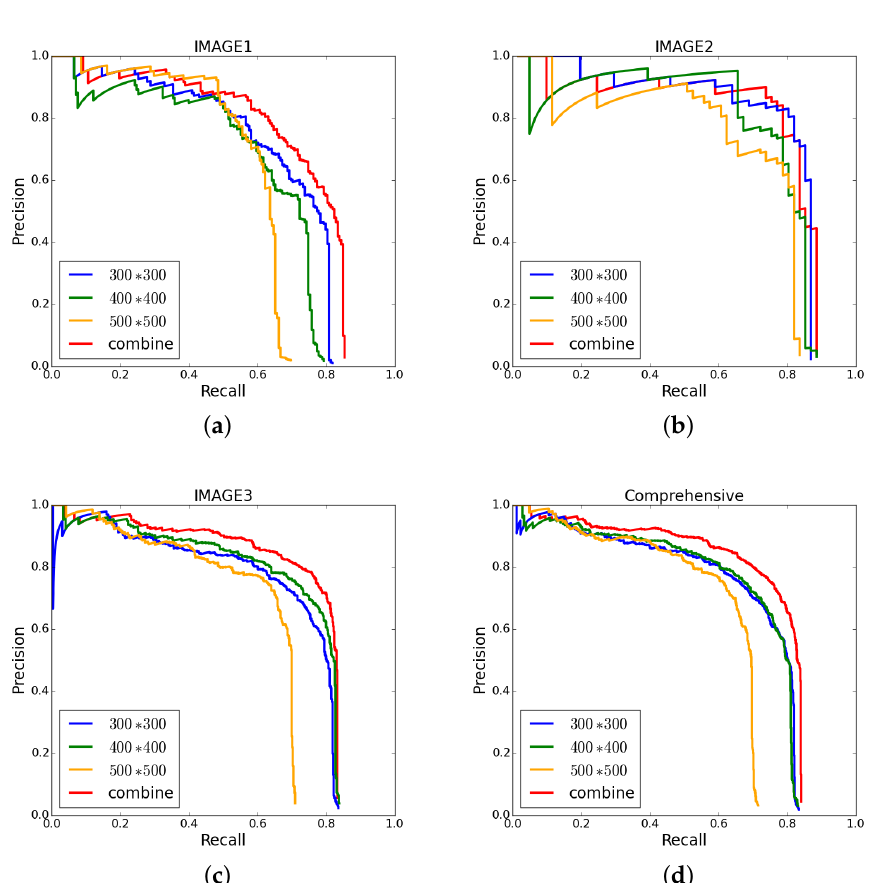
Figure 17. Performance comparison of using each single cutting size (300 × 300, 400 × 400 and 500 × 500) and using the multi-scale detection strategy (combined) on the testing set in terms of the P-R Curves. ( a ) Comparison of detection performance on IMAGE1. ( b ) Comparison of detection performance on IMAGE2. ( c ) Comparison of detection performance on IMAGE3. ( d ) Comparison of detection performance on the whole testing data